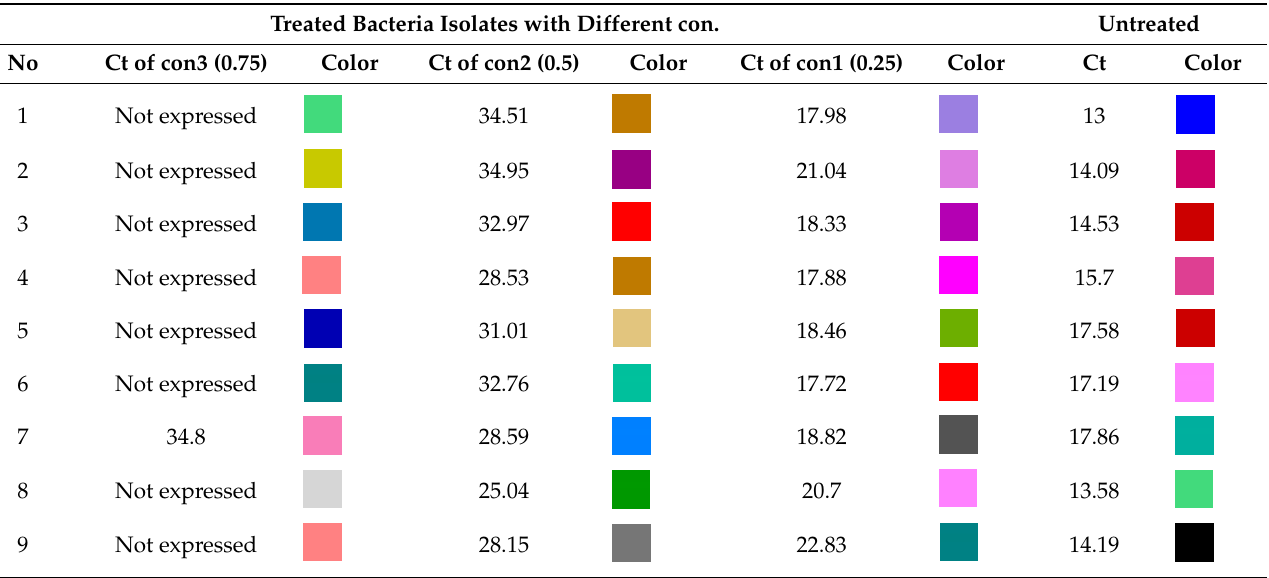
Table 4. kfu gene expression in Klebsiella pneumoniae isolates treated with different concentrations of ZnO NPs *.